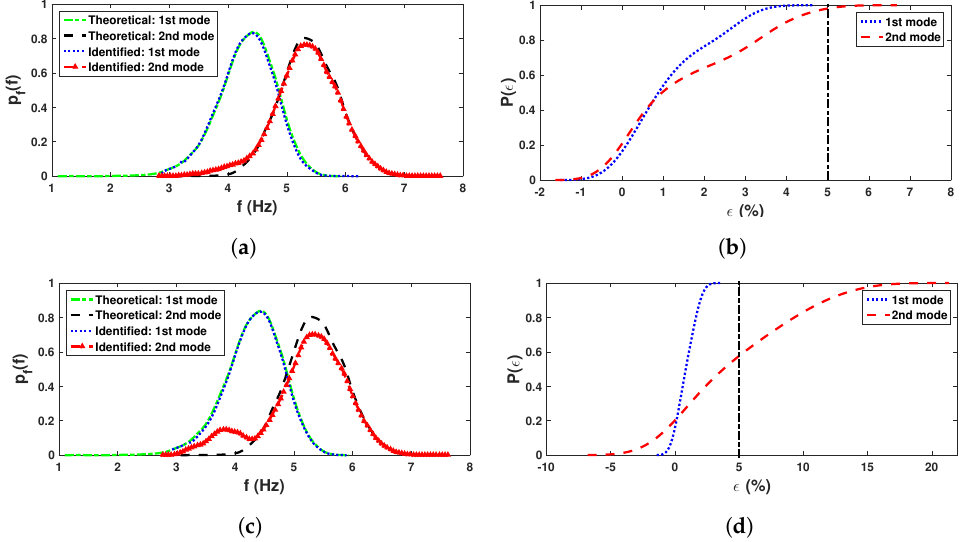
Figure 6. Comparison between theoretical and identified: ( a ) identified pdf s & ( b ) cdf s of error from 1st dof response; ( c ) identified pdf s & ( d ) cdf s of error from 2nd dof